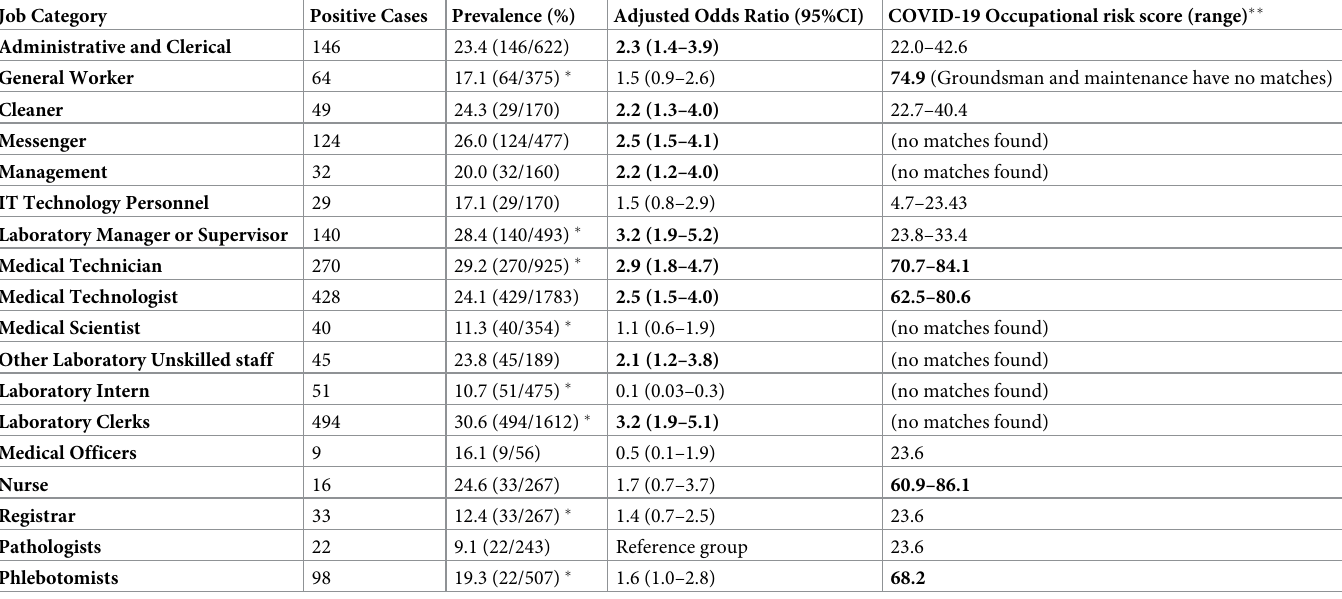
Table 3. Prevalence proportion of COVID -19 cases within the medical laboratory services staff and within international HCWs job categories. Job